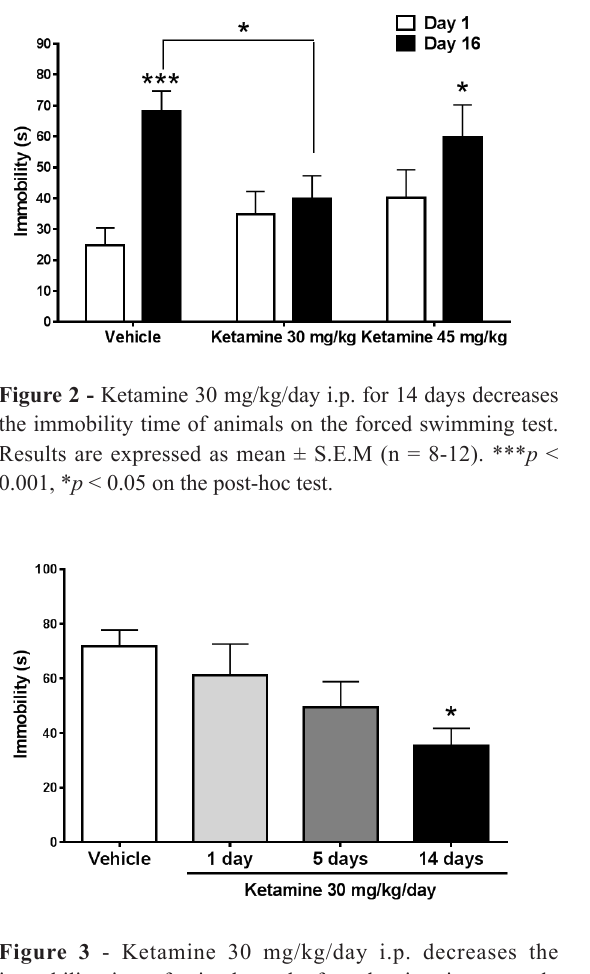
Figure 3 - Ketamine 30 mg/kg/day i.p. decreases the immobility time of animals on the forced swimming test only when administered for 14 days. Results are expressed as mean ± S.E.M (n = 11-12). * p < 0.05 on the post-hoc